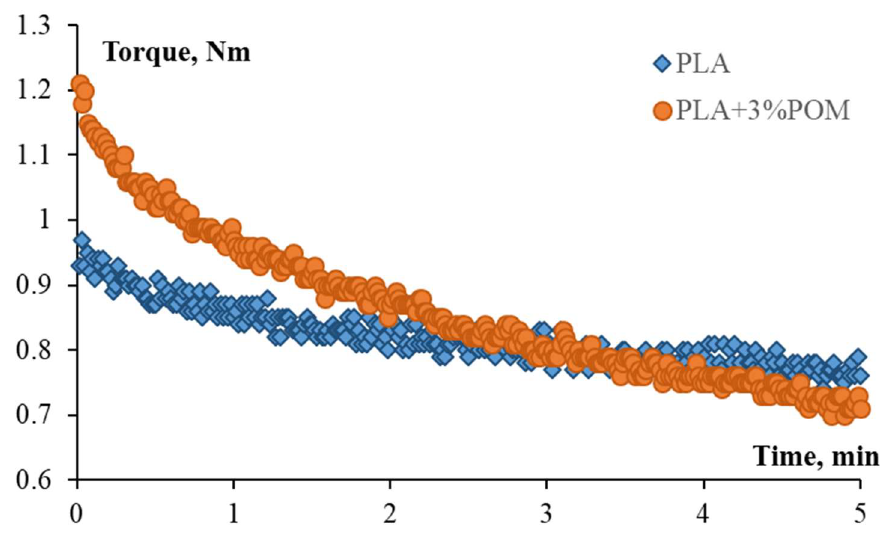
Figure 3. Evolution of torque over time during compounding of Exr. PLA and Extr. POM/PLA materials.